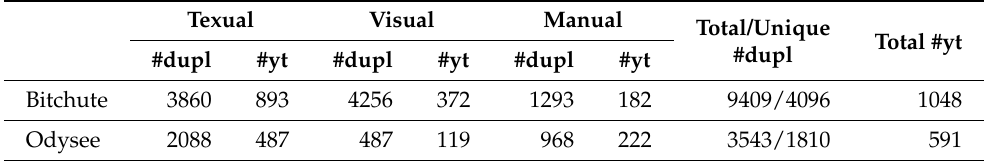
Table 3. Number of BitChute and Odysee videos retrieved by each filtering process and the number of YT videos they correspond to. Texual